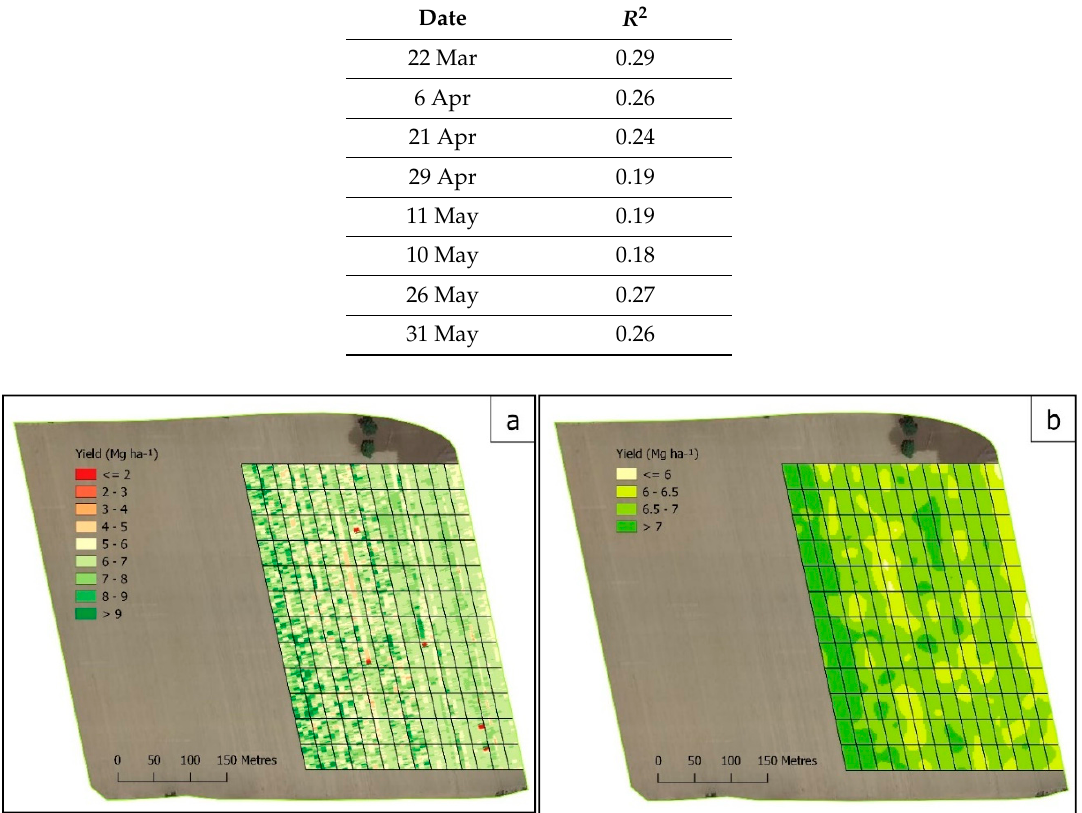
Figure 6. ( a ) yield map used for quantitative analysis; ( b ) generalized version of yield map.